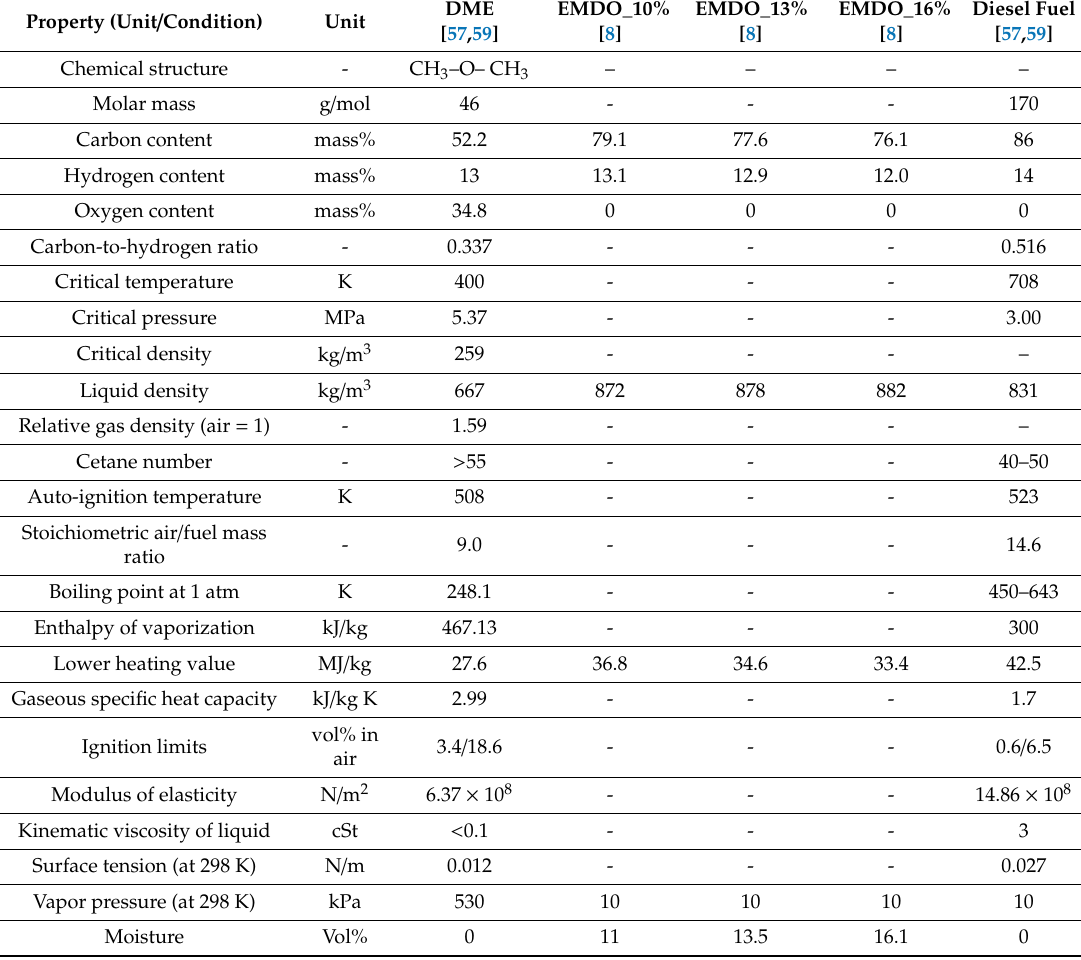
Table 4. Properties of MDO, emulsified MDO (EMDO), and DME